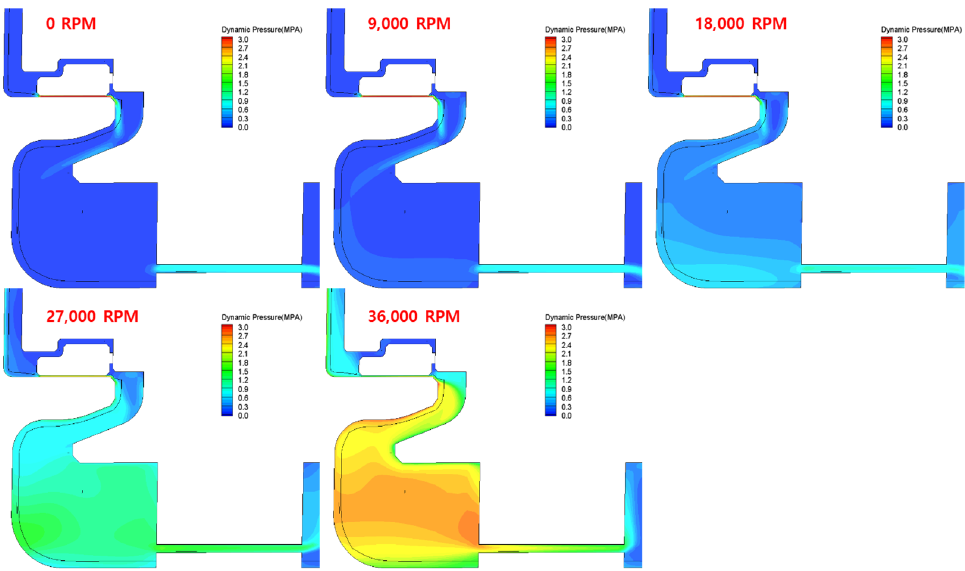
Figure 9. Dynamic pressure (MPa) distributions with rotating speed variation.